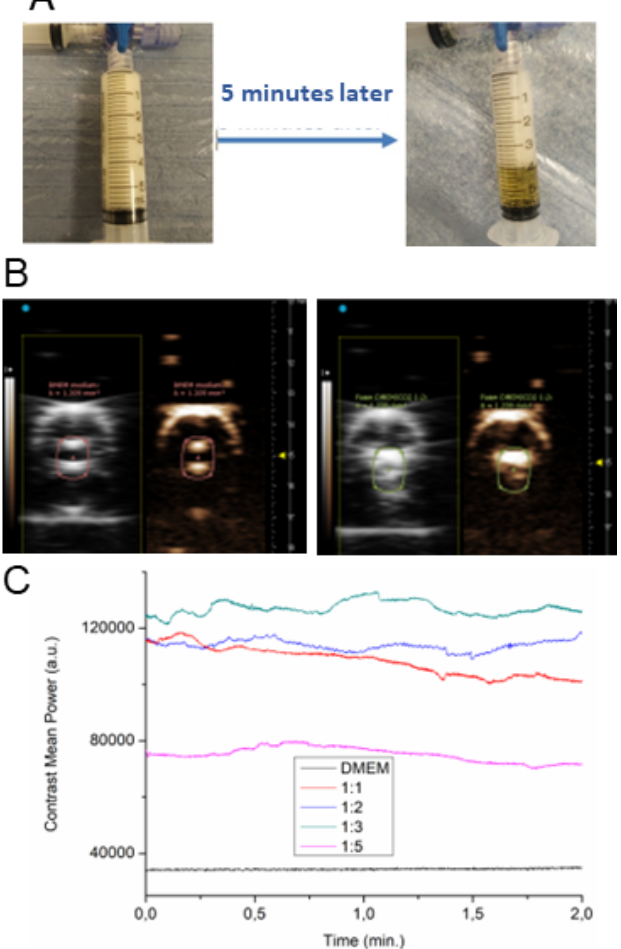
Figure 1. In vitro evaluation of CO 2 foam. ( A ) CO 2 foam prepared by mixing DMEM&FBS medium and carbon dioxide (1:2) immediately after preparation (left picture) and 5 min later (right). ( B ) NLC imaging of CO 2 foam in phantoms. US (left) and NLC phantom imaging (right) of DMEM&FBS medium (left panel) and DMEM&FBS:CO 2 1:2 v / v foam (right panel). ( C ) Contrast signal obtained from pure DMEM&FBS medium and different DMEM&FBS:CO 2